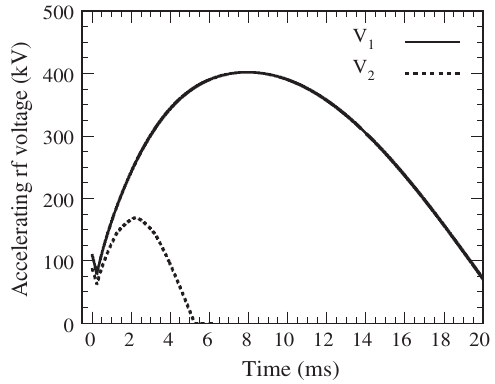
FIG. 5. The rf voltages used for RCS beam acceleration. The V 2 is applied until 5 ms from the beam injection, while it is kept 80% of V 1 for the first 1 ms, in order control the charge density of the beam and reduce the effect of space charge at a lower beam